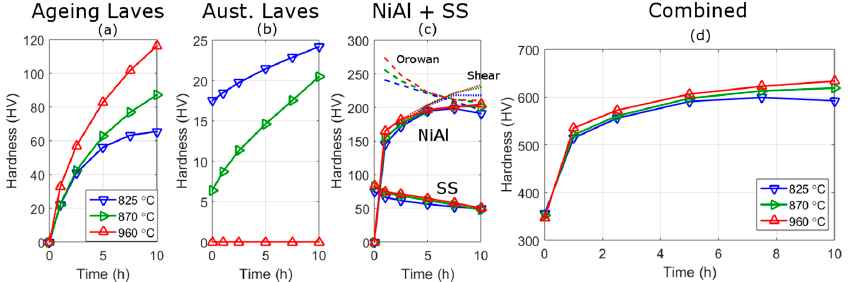
Figure 10. Hardness strength prediction based on the SANS analysis and mechanical strengthening Equations (1)–(5) for the ageing Laves phase ( a ); austenitisation Laves phase ( b ); NiAl phase and solid solution strengthening (SS) ( c ); and the combination of the strengthening mechanisms ( d ). The results